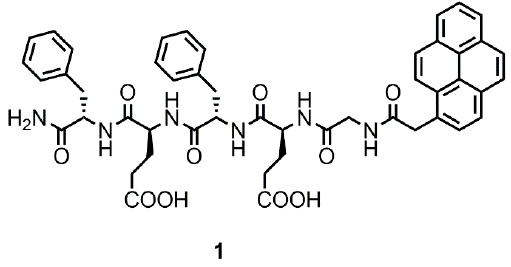
Figure 1. Structure of the pyrene–peptide conjugate 1